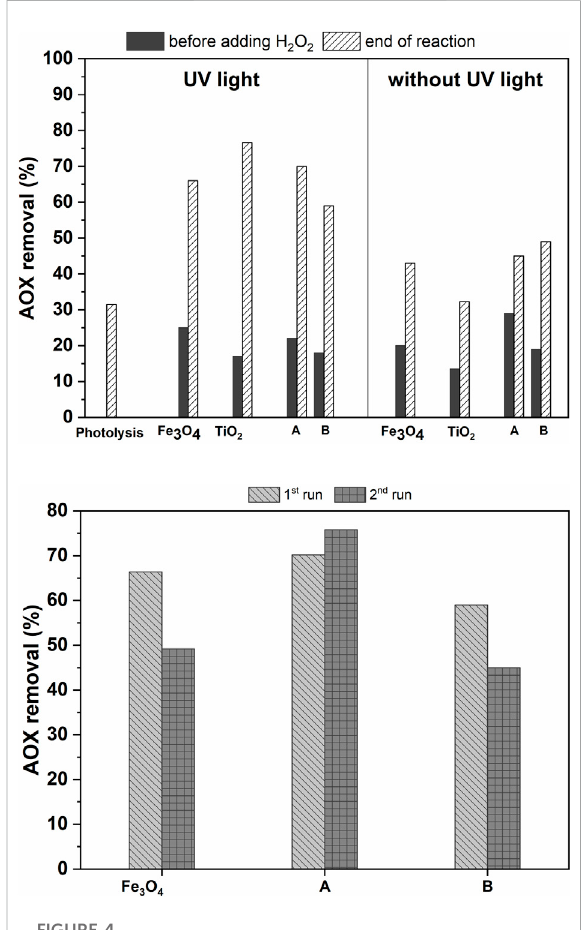
FIGURE 4 AOX removal in a real aqueous ef fl uent as a function of photocatalyst used (A) in the presence or absence of UV light irradiation (top) and in two consecutive photocatalysis runs using Fe 3 O 4 and Fe 3 O 4 /TiO 2 -A and B photocatalysts (bottom). Reaction conditions: 2 mg of photocatalyst; AOX ef fl uent (200 ml); 30 wt%, H 2 O 2 (9.8 mmol); 57 ° C; 1 h reaction time.